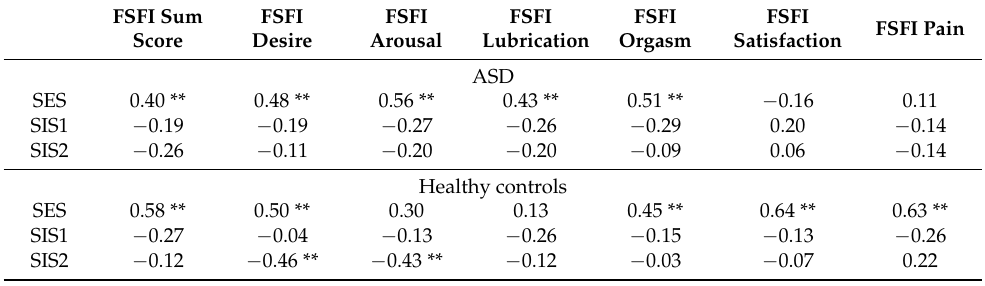
Table 4. Correlational analysis between the sexual inhibition/sexual excitation scales short form (SIS/SES) and female sexual functioning assessed with the female sexual function index (FSFI).